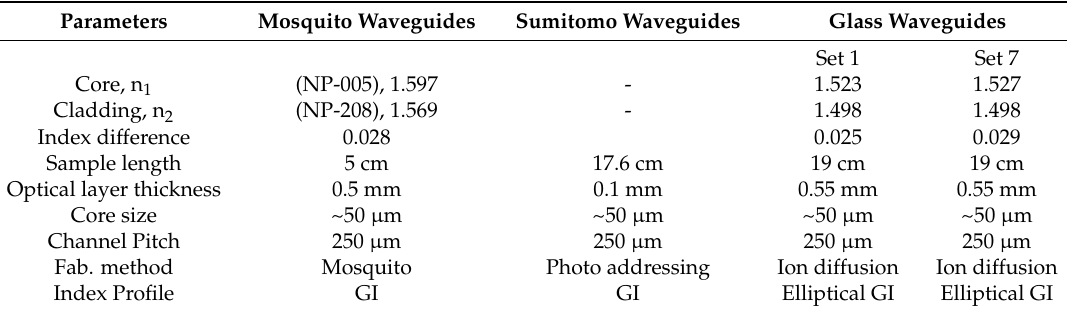
Table 2. Polymer and glass waveguide parameters.